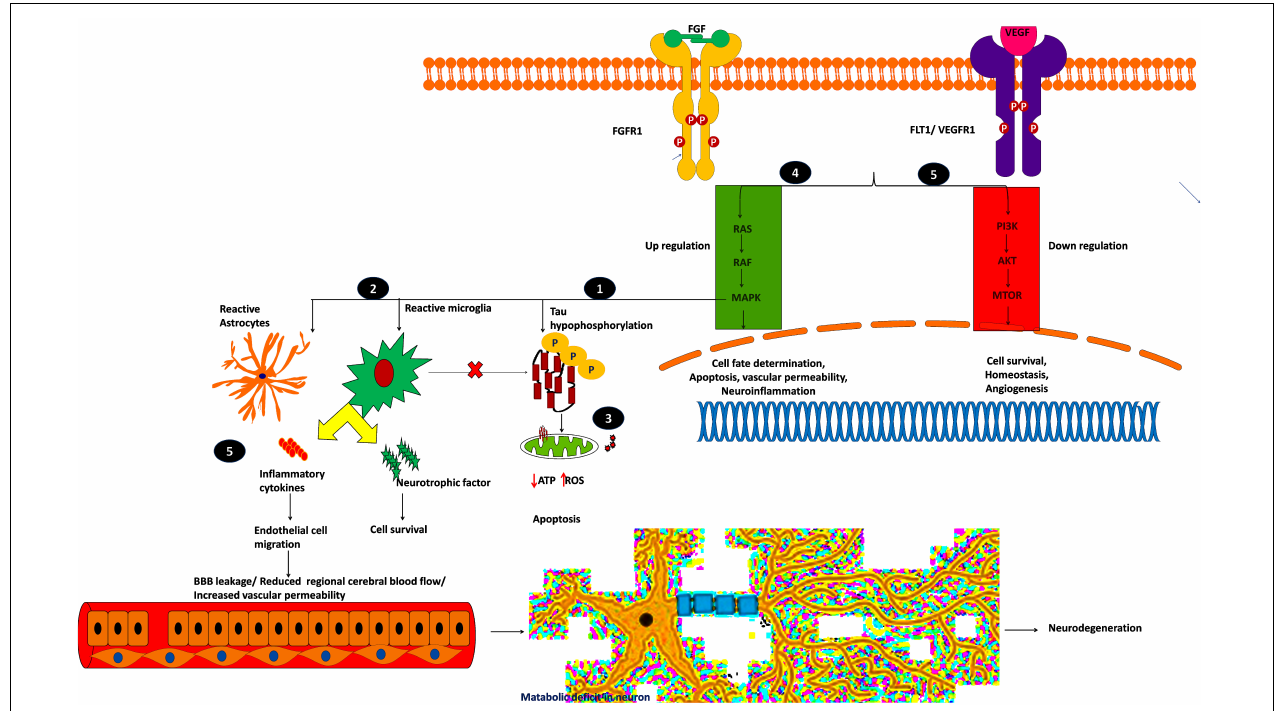
FIGURE 7 | Plausible mechanism of proposed possible drug targets to reduce BBB permeability and